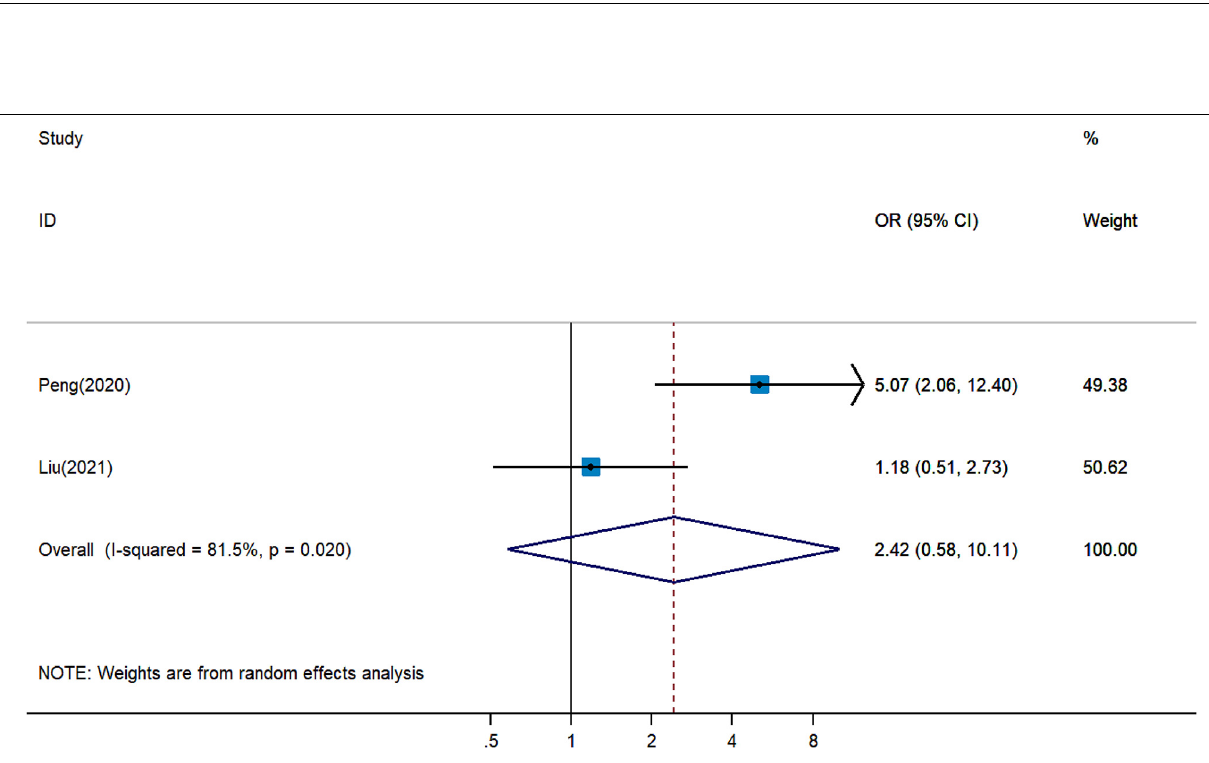
Frontiers in Nutrition |